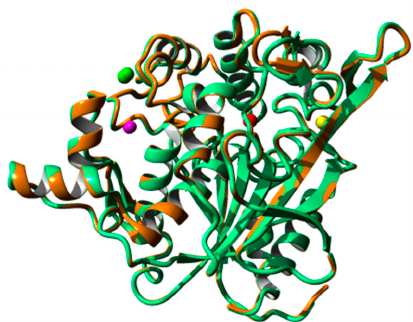
Figure 8. Superimposed of 5M mutant modeled structure (color in gold) with T1 lipase crystal structure (color in green). The calcium ion, zinc ion, sodium ion, and chloride ion shown as sphere color by yellow, magenta, red, and green, respectively.